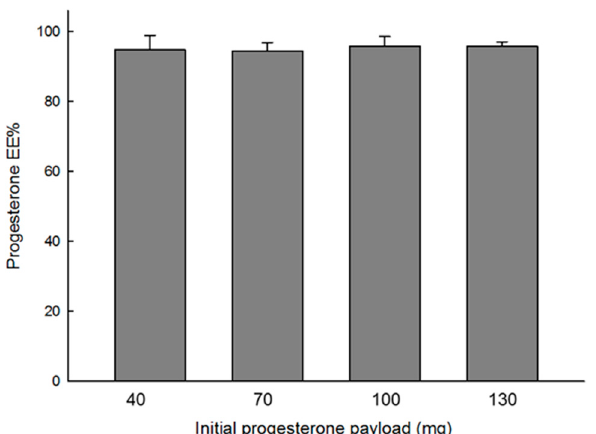
Figure 2. Effect of an initial progesterone amount used for microencapsulation upon its encapsulation efficiency (EE)%. The amount of poly- d,l -lactide- co -glycolide (PLGA) was fixed at 250 mg. The ethyl formate-based microencapsulation process provides almost complete encapsulation of progesterone into PLGA microspheres.